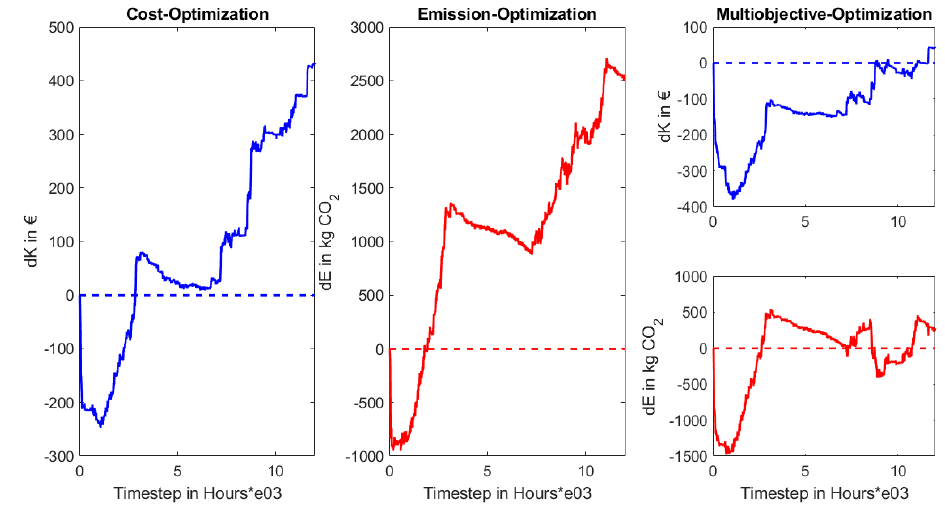
Figure 15. Di ff erence of cumulated targets for scenario #1, left: Results of Optimization of operation cost, mid: Results of optimization of CO 2 emissions, right: Results of multi-objective optimization